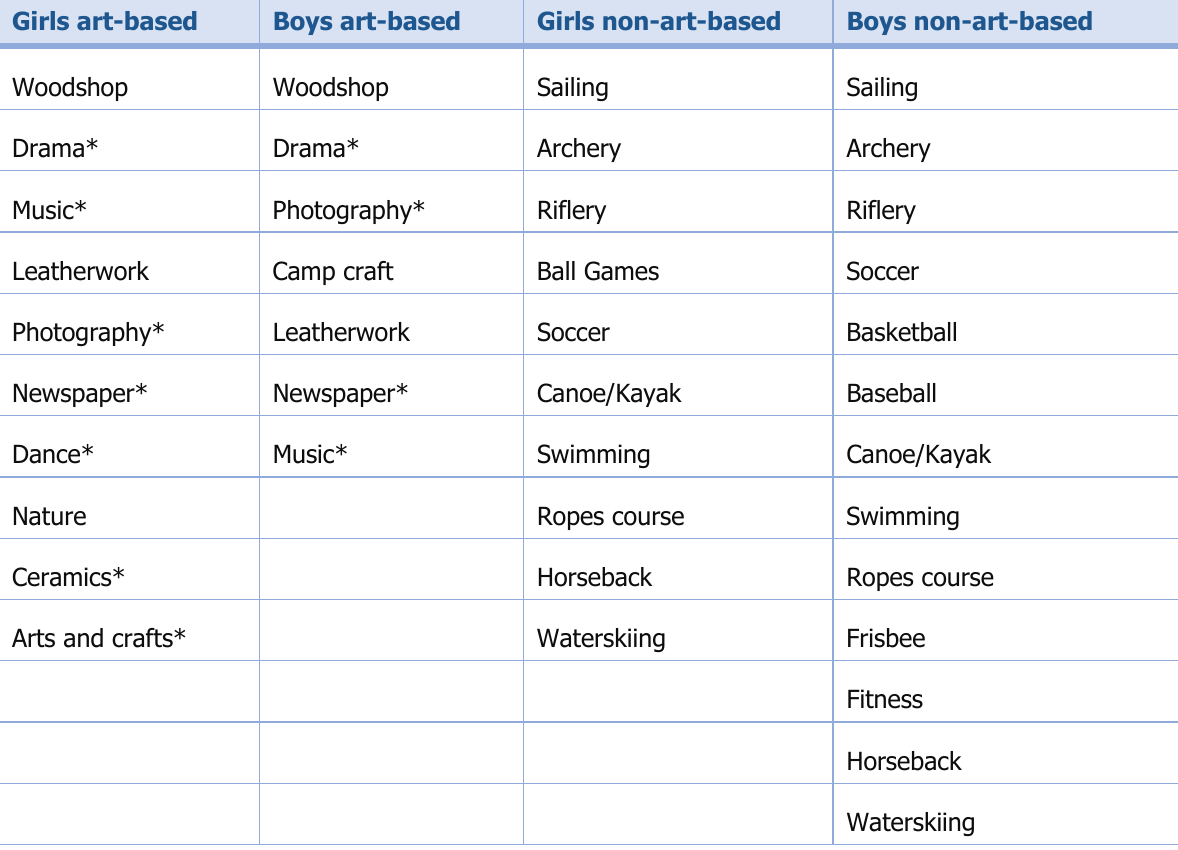
Table 1. Differences between Camp Programs Based on Artistic and Non-Artistic